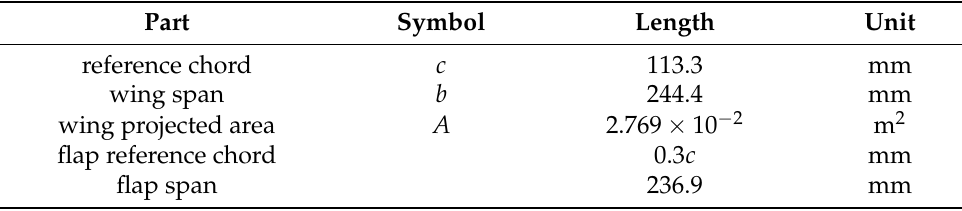
Figure 2. The WTT model and the integrated flap actuating system. ( a ) External appearance. ( b ) Installed drive mechanism. ( c ) Magnified view of the drive mechanism; (1): flap; (2): linkage; (3): DC servo motor; (4): motor controller. Table 1. Dimensions of the WTT